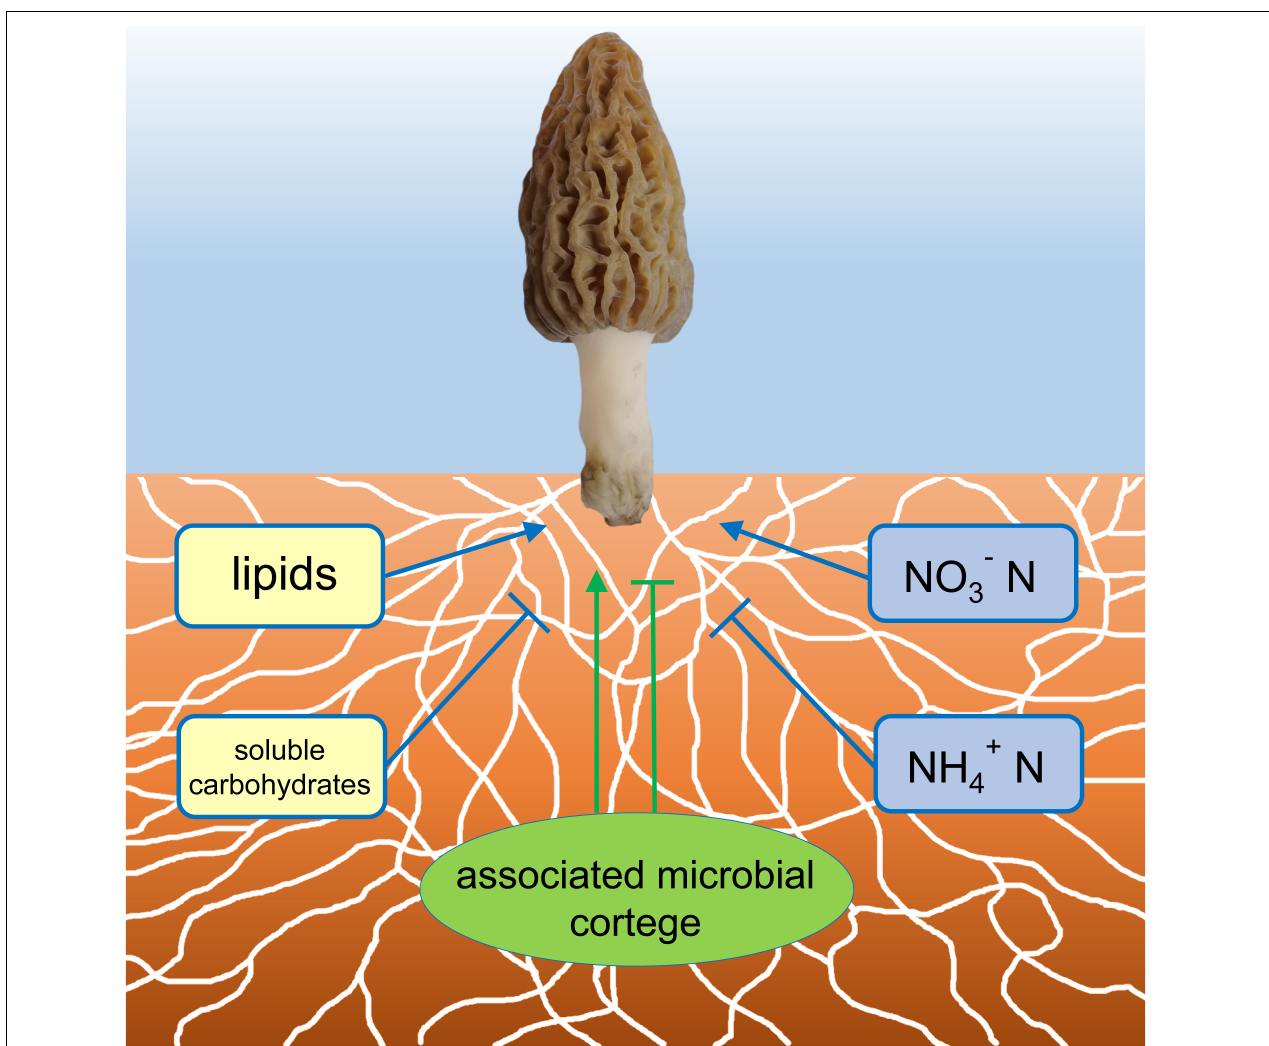
FIGURE 7 | A conceptual illustration of the ecophysiological factors in the morel-cultivating substratum influencing the fructification. Factors with positive influences were indicated with arrows, while those with negative influences were indicated with T-terminal